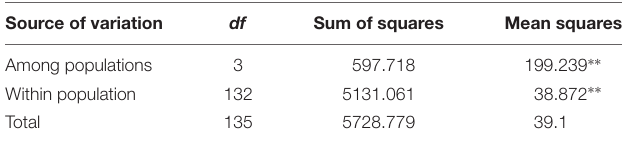
TABLE 4 | Analysis of molecular variance (AMOVA) for 136 sorghum accessions among and within four subpopulations as identified by STRUCTURE. Sum of squares Mean